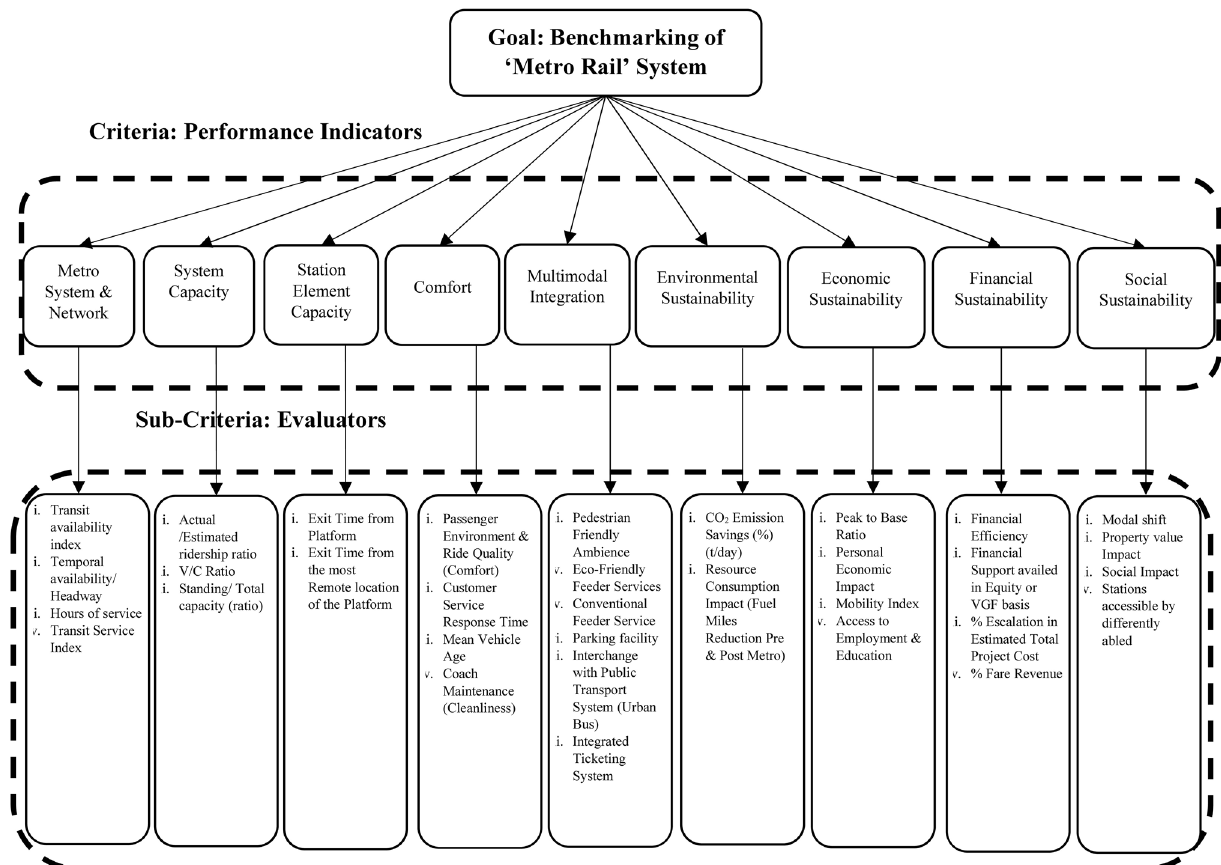
Fig. 1 Hierarchy of proposed integrated and sustainable benchmarking framework for a metro